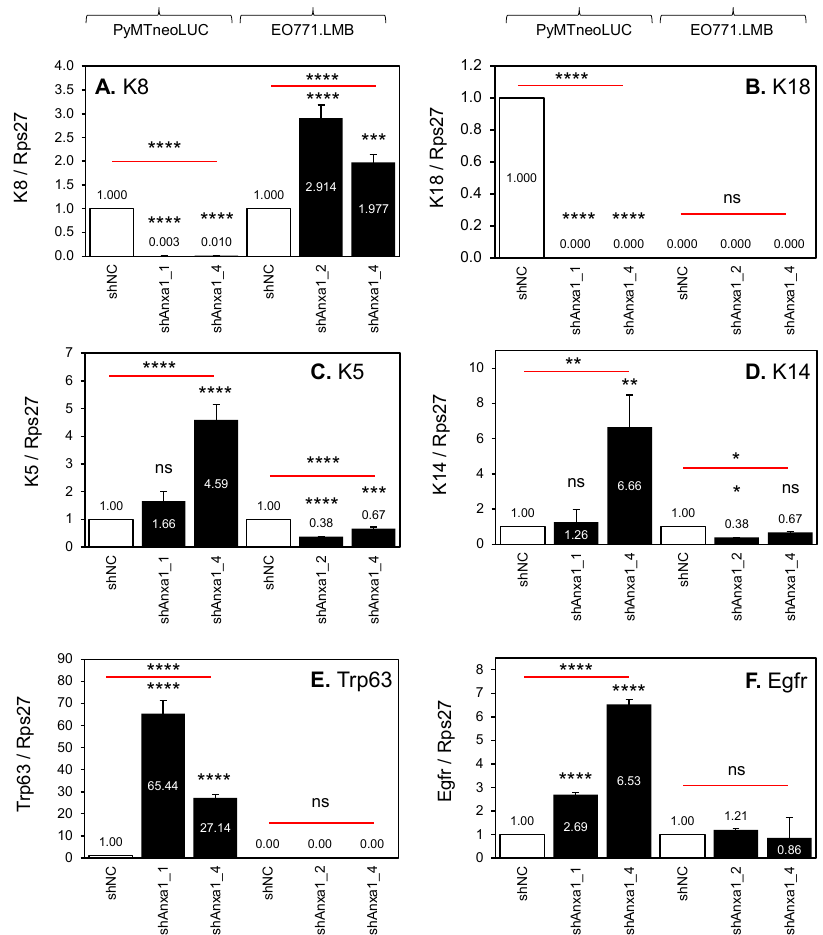
Figure 6. Expression of basal and luminal mammary epithelial cell markers in mouse mammary tumor cell lines harboring Annexin A1 knockdown qRT-PCR analysis was conducted on the indicated cell lines as described in the Materials and Methods. Gene expression was normalized to Rps27 levels and set to 1 in control PyMTneoLUC_shNC and EO771.LMB_shNC cell lines. ( A ) Luminal cytokeratin 8 (K8). ( B ) Luminal cytokeratin 18 (K18). ( C ) Basal cytokeratin 5 (K5). ( D ) Basal cytokeratin 14 (K14). ( E ) Basal Trp63. ( F ) Basal Egfr. Mean ± SD ( n = 3). Data were analyzed using one-way ANOVA followed by Dunnett’s post hoc test for multiple comparisons to compare to control shNC cells. *, p < 0.05. **, p < 0.01. ***, p < 0.001. ****, p < 0.0001. ns (not significant).